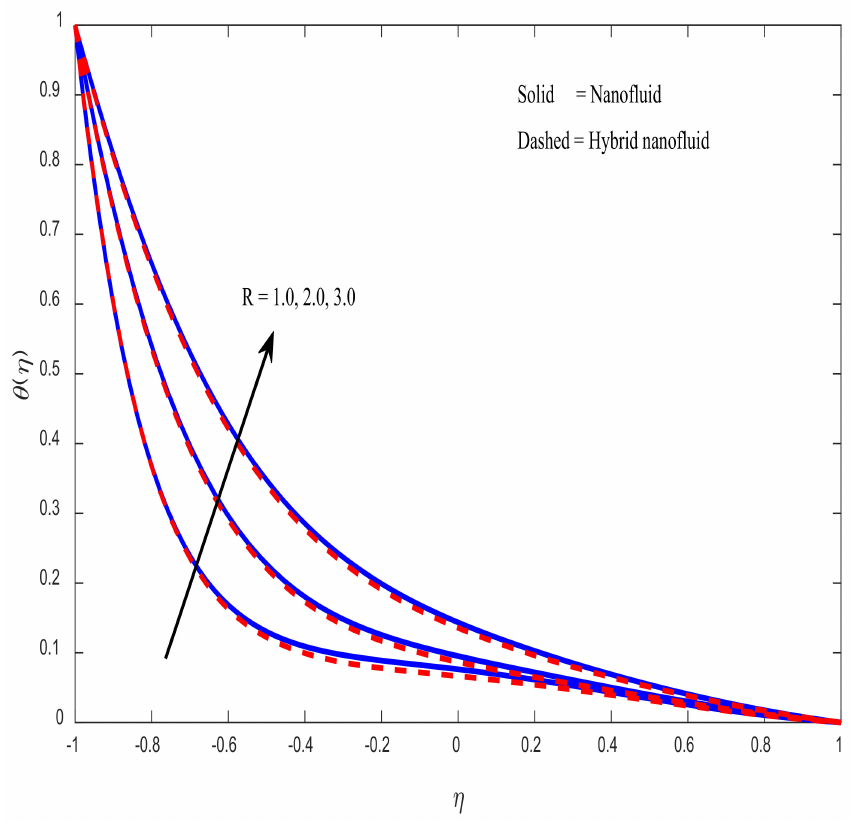
Figure 7. Influence of R on the temperature profile.